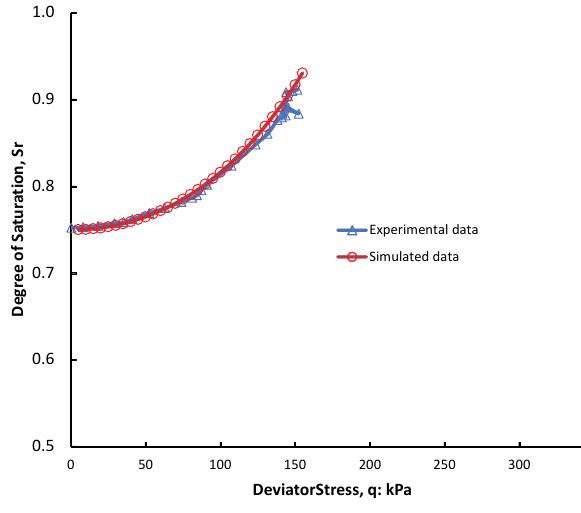
Fig. 2. Degree of saturation against deviatoric stress in triaxial test at constant suction – experimental results (Shivkumar [28]) and numerical